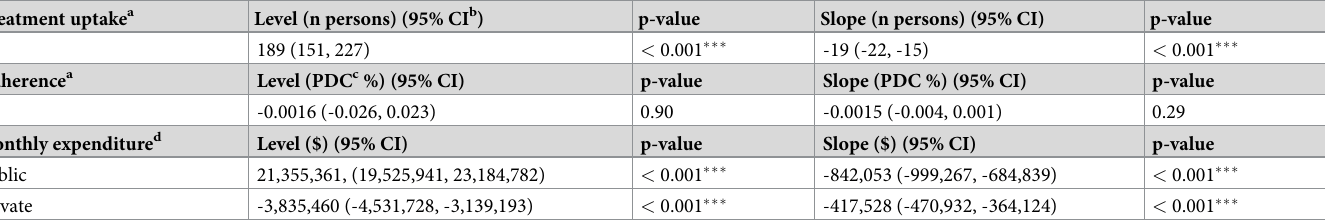
Table 3. Results from interrupted time series analyses for the impact of PharmaCare on treatment uptake, adherence and monthly expenditure of sofosbuvir and ledipasvir-sofosbuvir. Treatment uptake a